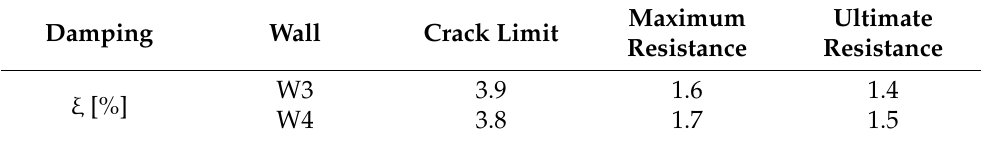
Table 11. Equivalent viscous damping for characteristic limit states of W3 and W4 ( σ v = 0.8 N/mm 2 ).